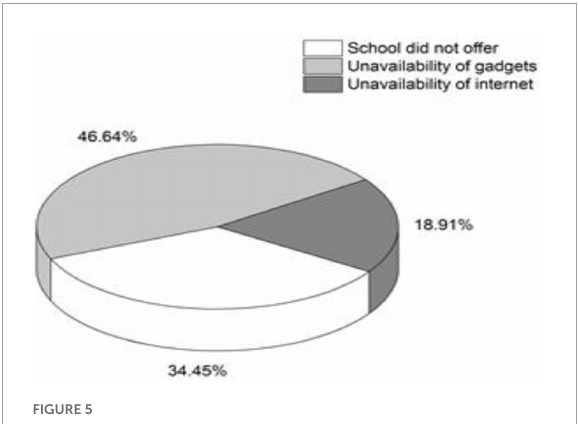
Reasons for not accessing online education during school